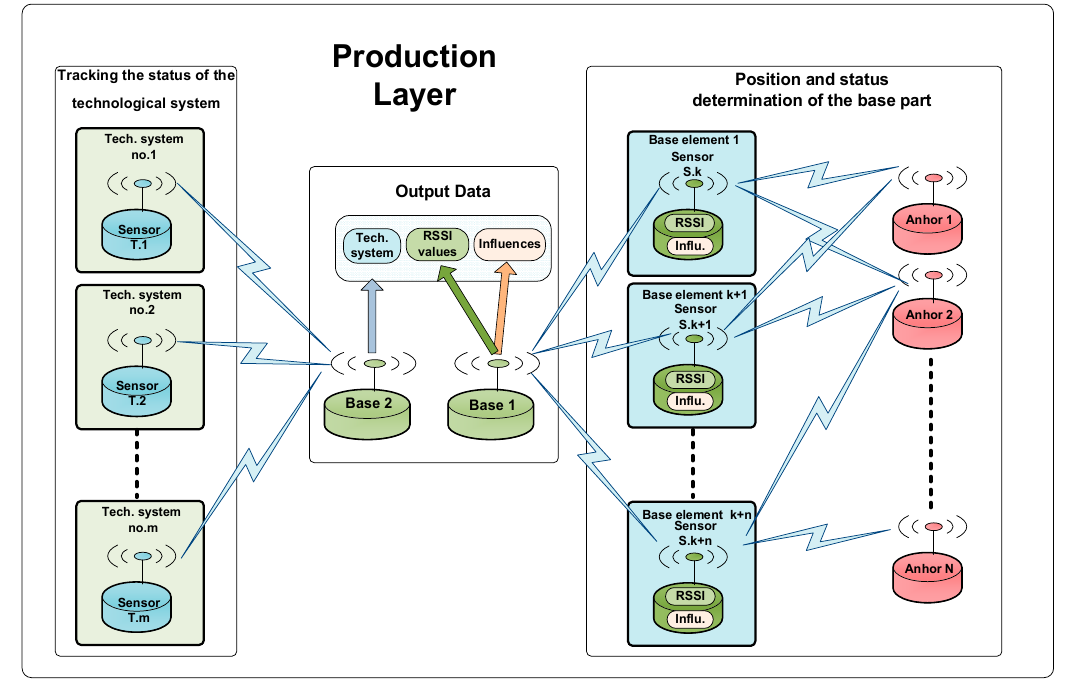
Figure 2. The “Production” layer.